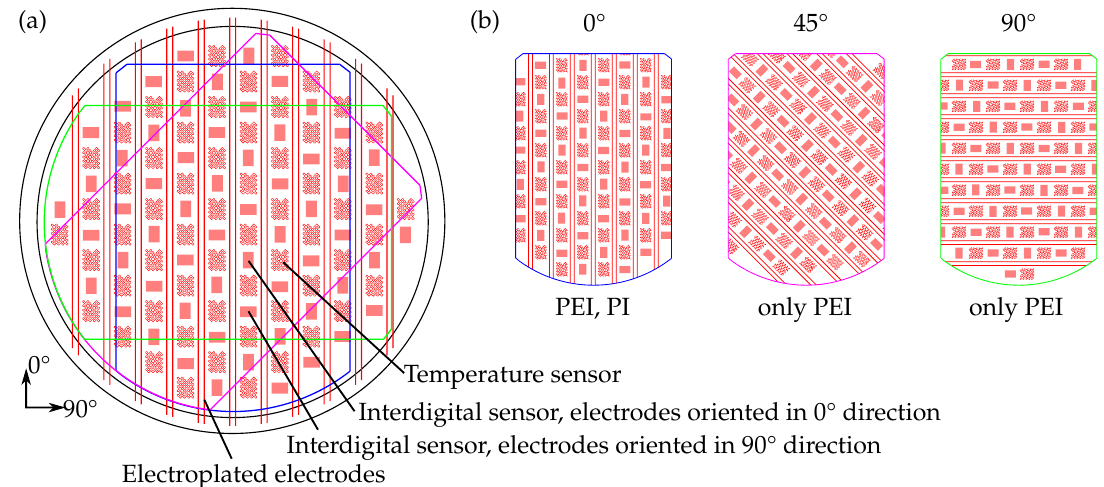
Figure 3. Sensor pattern for DCB testing: ( a ) Sensor pattern on a 100 mm diameter wafer. ( b ) Cut sensor patterns under different angles for